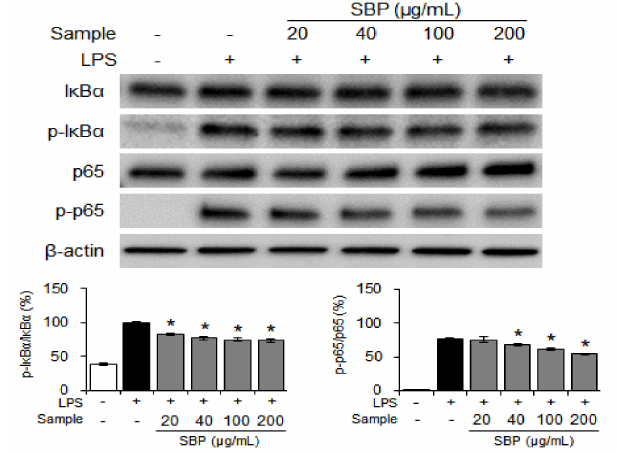
Figure 4. Effects of the SBP extract on NF − κ B protein expression in Raw264.7 cells. Data are expressed as mean ± SEM. Significantly different from the LPS-treated group (* p < 0.05). SBP, sword bean pod; LPS, lipopolysaccharide. NF − κ B, nuclear factor kappa B; I κ B α , inhibitor of the transcriptional factor NF- κ B, p-, phosphorylated.